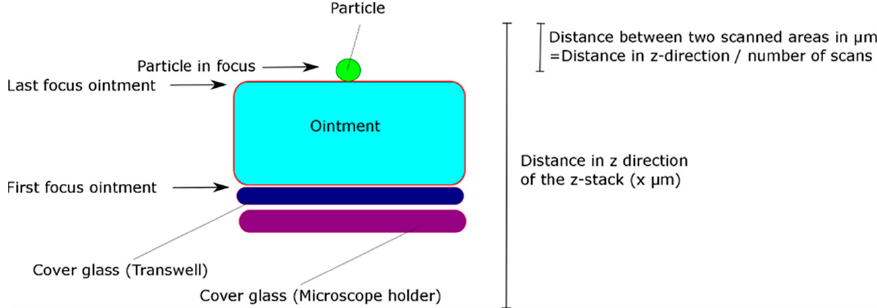
Figure 2. Situation for observing pollen penetration into ointment film preparation by confocal laser microscopy (CLSM) (not to scale).